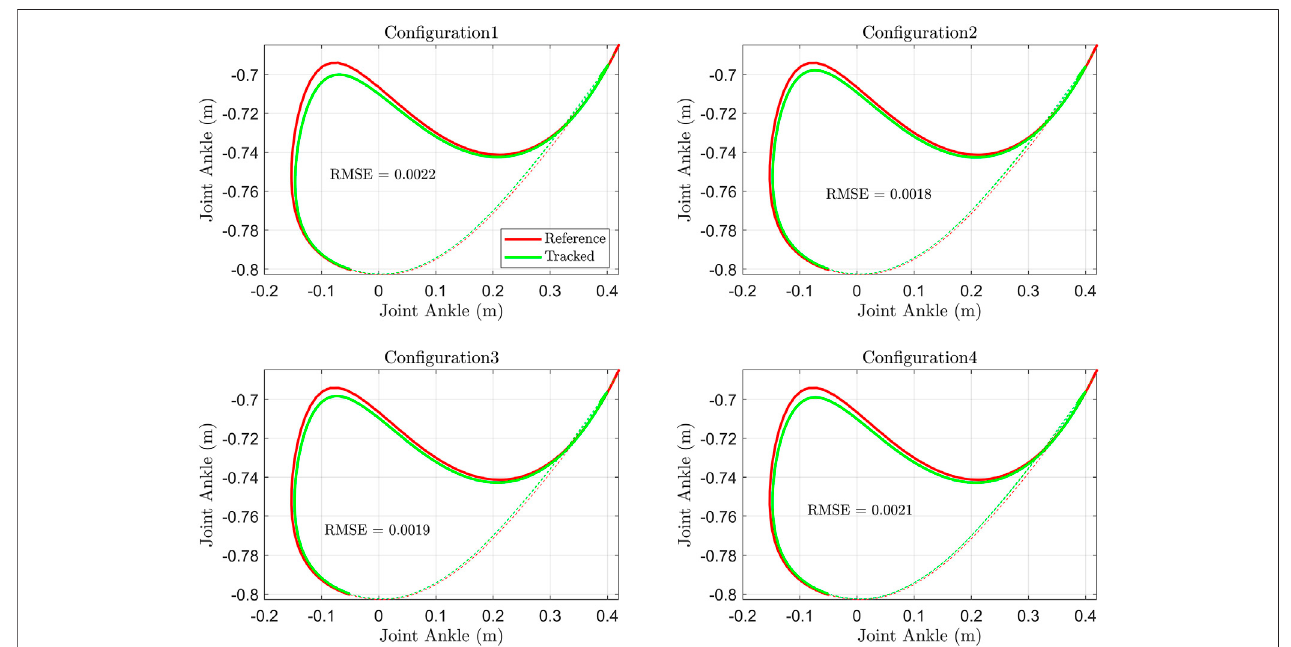
FIGURE 7 | Ankle joint position (Hip joint as reference) and RMSE of the ankle distance tracking error.